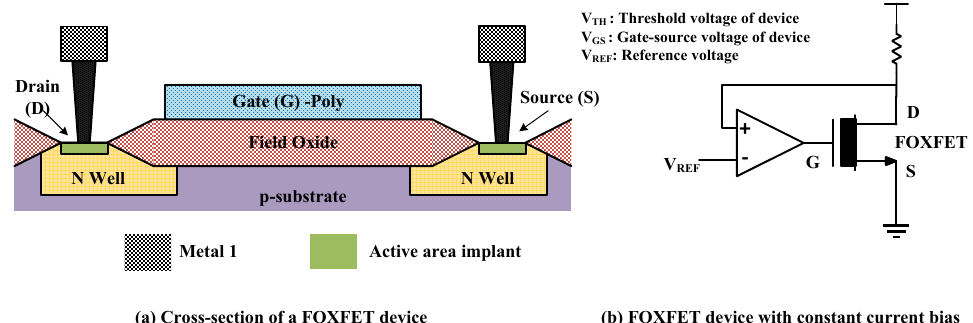
Figure 5. ( a ) Cross-section of a field-oxide field-effect transistor (FOXFET) device used in dosimeter and ( b ) readout circuit for threshold voltage measurement of a FOXFET based